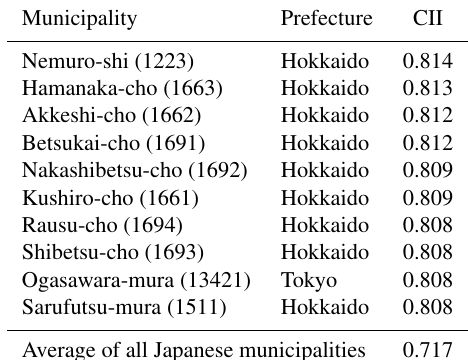
Figure 6. Histogram of average CII over the study period (FY 2014–2016) for each municipality in Japan. Red, green, and blue dashed lines represent the average CII of Beijing, Seoul, and Tokyo (23 wards), respectively.